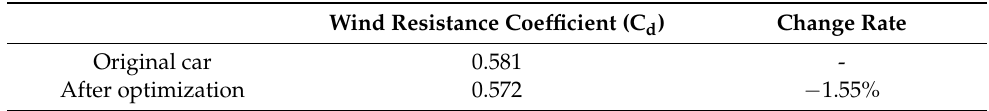
Table 1. Wind resistance coefficients of the commercial